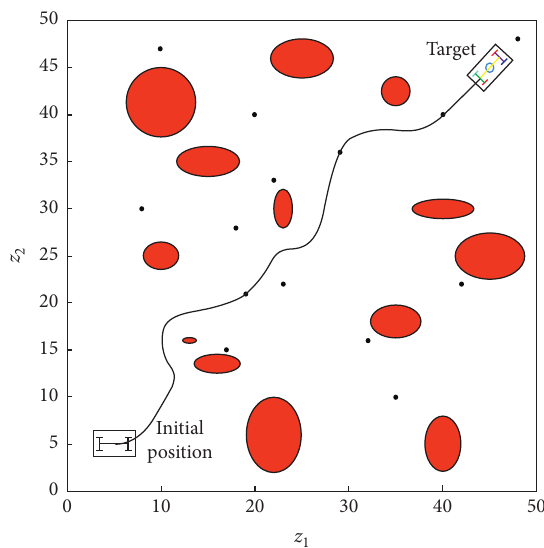
Figure 10: Landmark navigation of a car-like robot in an obstacle- ridden workspace with initial position at ( 5 , 5 ) and target at ( 45 , 45 ) .